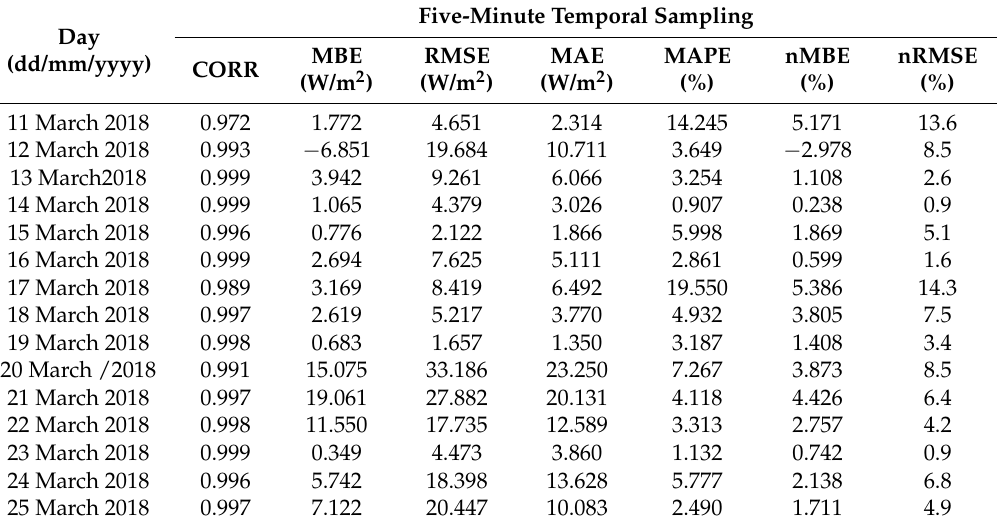
Table 5. Results of the statistical assessment for AMESIS product based on five-minute temporal sampling against ground measurements at the Ispra site.